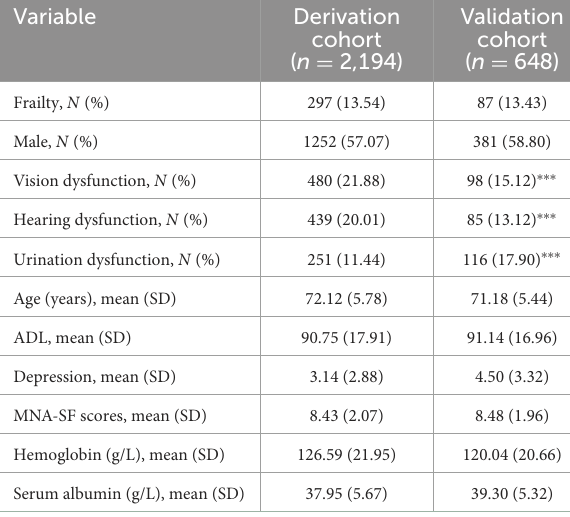
TABLE 1 Participants’ characteristics in cohort